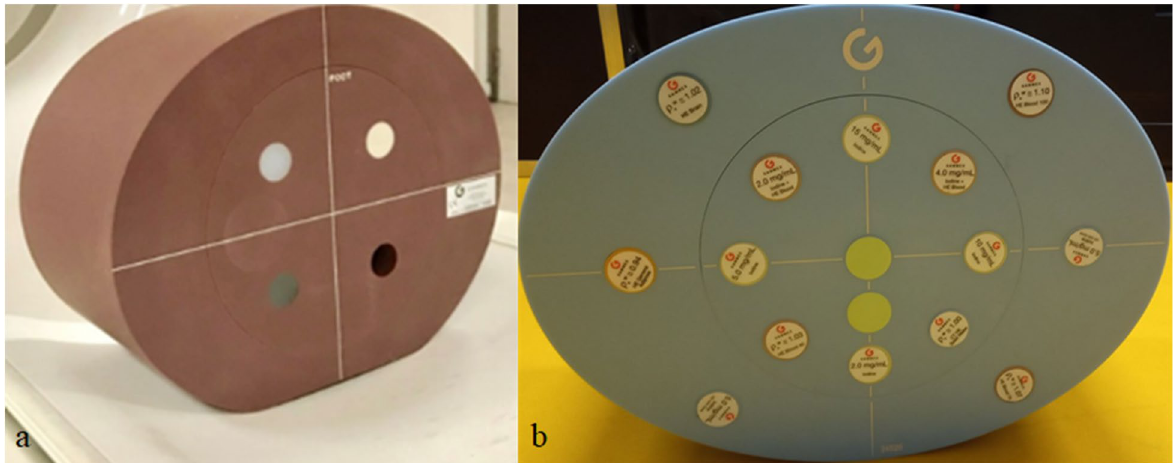
Fig. 1 Images of the phantoms used: a ACR CT 464 phantom. b Multienergy CT phantom. CT Computed